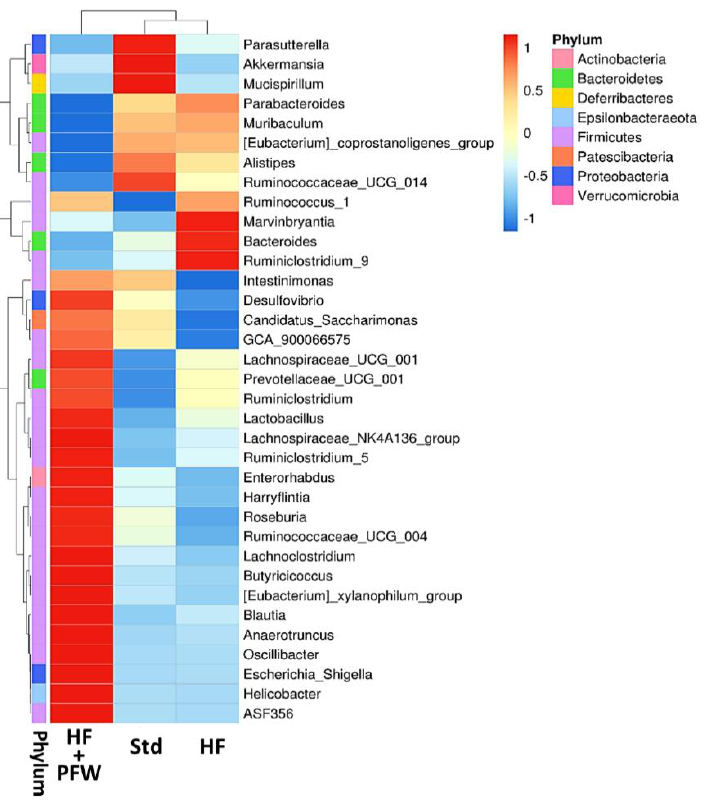
Figure 7. Taxa analysis of gut microbiota composition in mice by heatmap. Heatmap represents relative abundance of taxa on a color gradient. The top 35 most abundant genus taxa are shown. Group Std, standard diet; group HF, high-fat diet; group HF+PFW, high-fat diet plus PFW treatment.